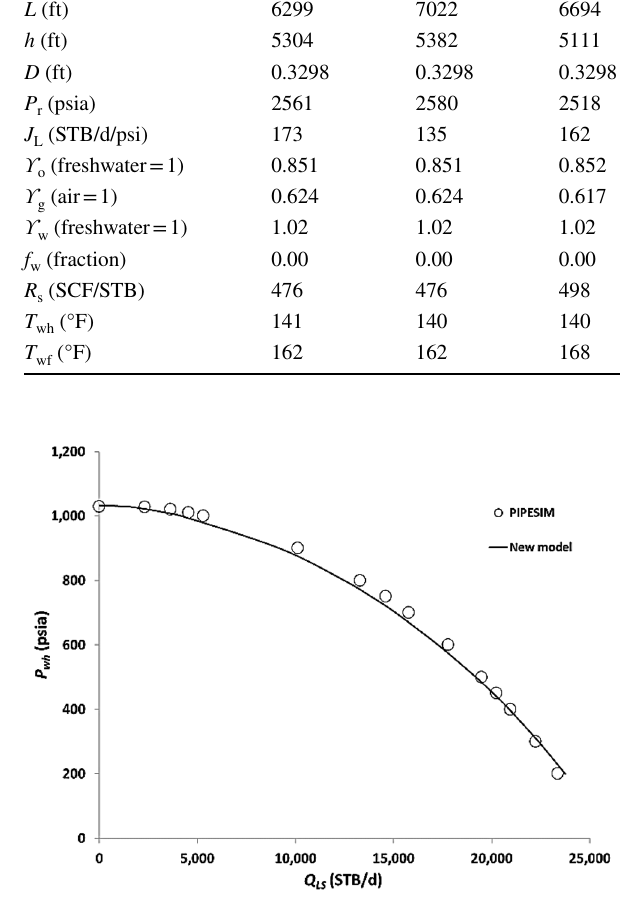
Fig. 4 Comparison of models for well